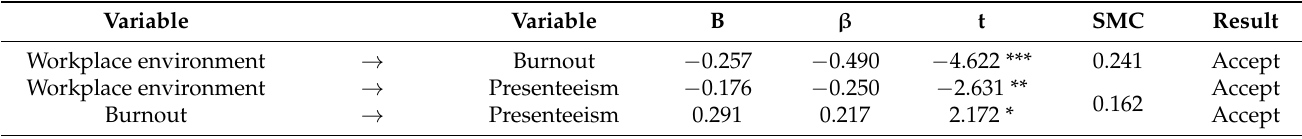
Table 6. Structural equation model (SEM) analysis